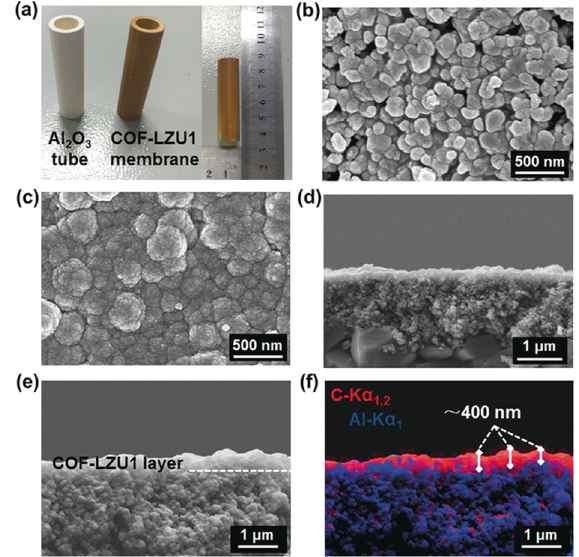
Figure 7. ( a ) Photographs of an untreated Al 2 O 3 tube and a tubular COF-LZU1 membrane. ( b , c ) Top-view SEM images of an untreated Al 2 O 3 tube ( b ) and a tubular COF-LZU1 membrane ( c ). ( d , e ) Cross- sectional SEM images of an untreated Al 2 O 3 tube ( d ) and a tubular COF-LZU1 membrane ( e ). ( f ) EDXS (Energy-dispersive X-ray spectroscopy) mapping of the cross-section of a tubular COF-LZU1 membrane and corresponding elemental distributions. C is the tracer for the COF layer, and Al is the tracer for the ceramic tube. Reprinted with permission from [78], Copyright (2018) John Wiley and Sons publications.